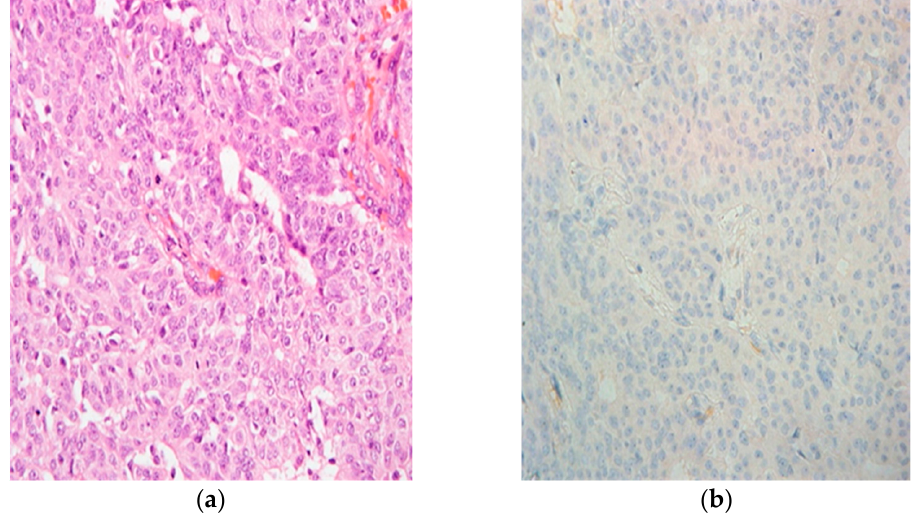
Figure 3. ( a ) Papillary structures with surrounding fibrous capsule (haematoxylin and eosin, H&E, × 400). ( b ) Tumor cells show negative uptake of stain (p63, ×400). Other than that, her bone scan and computed tomography (CT) for staging revealed no evidence of distant metastasis. The patient already completed oral hormonal therapy with tablet anastrozole and is currently well under routine follow-up by the surgical team.